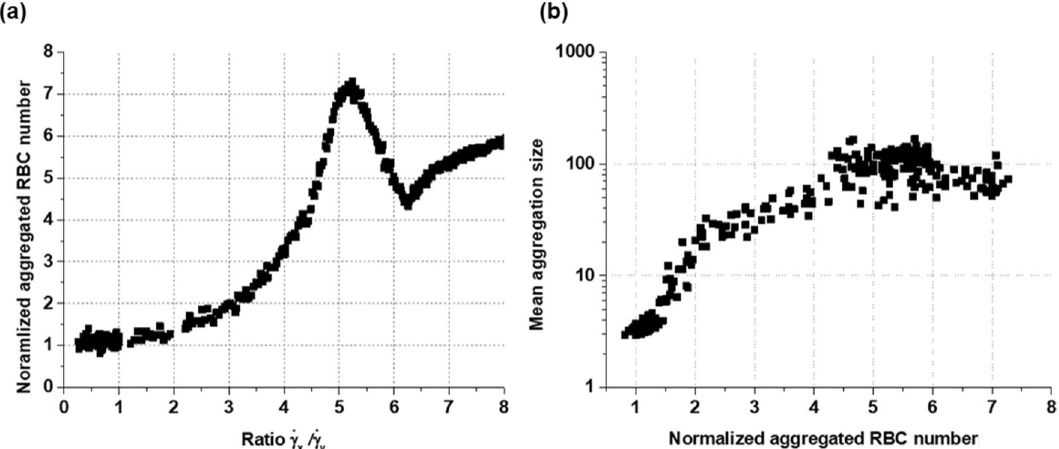
Figure 5. ( a ) Normalized aggregated RBC number as a function of the shear rate ratio between the axial and radial shear rates at the tube center area. Data were obtained from 300 different amplitudes of velocity from 0.1 to 5 mm/s with a mean flow velocity of 5 mm/s. ( b ) Mean aggregation size in a log scale as a function of the normalized aggregated RBC numbers.